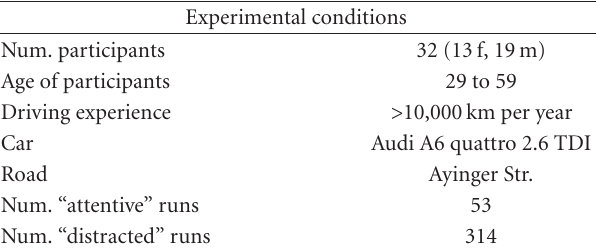
Table 3: Experimental conditions for driving data collection. Experimental